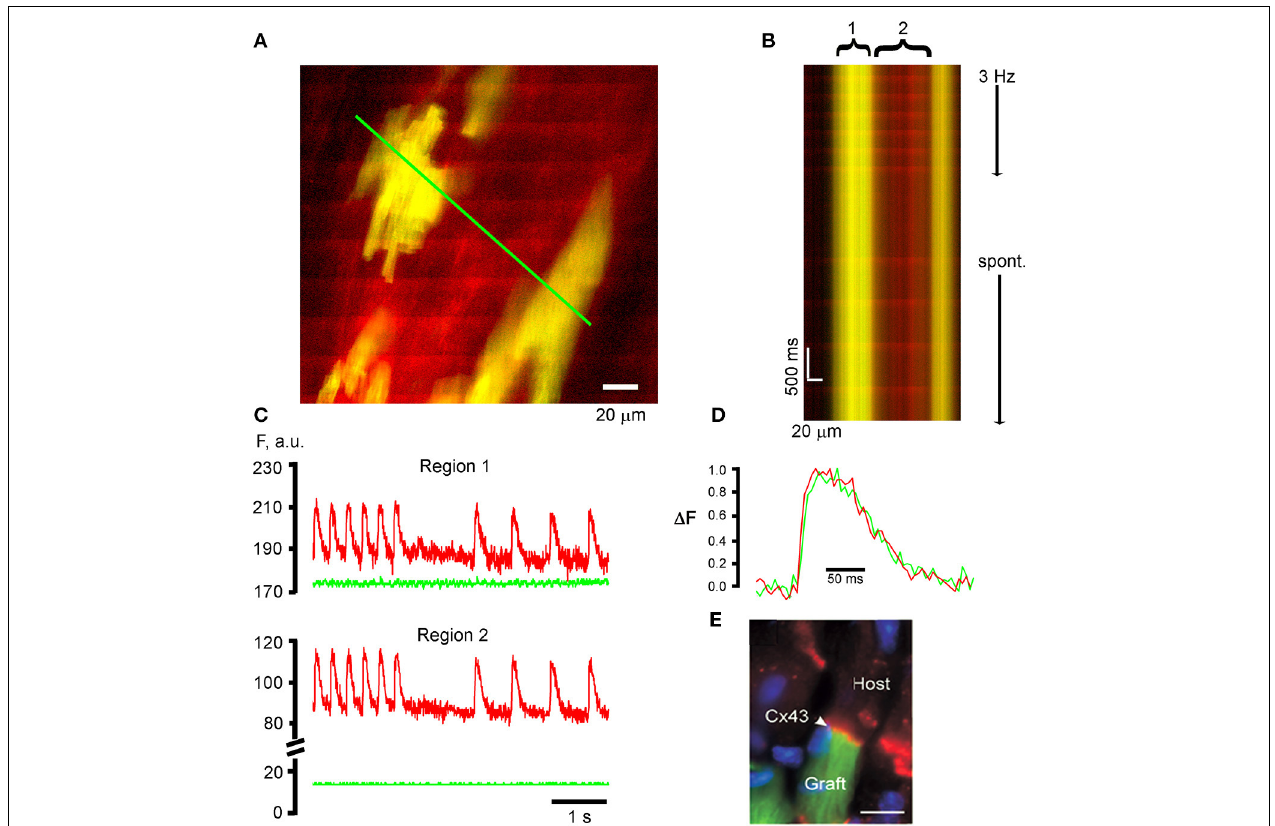
FIGURE 3 | TPLSM [Ca 2 + ] i imaging for functional assessment of intracardiac donor cell transplants. (A) PSC-derived cardiomyocytes participate in a functional syncytium with the host myocardium following their intracardiac transplantation. The frame mode image was taken from a rhod-2—loaded, Langendorff-perfused mouse heart at 21 days following intracardiac injection of 1,00,000 EGFP-expressing, PSC-derived cardiomyoctyes into a non-expressing mouse heart. Donor myocytes appear yellow due to the overlap of red rhod-2 fluorescence and green EGFP fluorescence. Periodic, ripple-like elevations in rhod-2 fluorescence intensity correspond to remote electrical stimulation (3Hz)-evoked [Ca 2 + ] i transients. (B) Line-scan image that was obtained by repeatedly scanning along the green line in (A) (500Hz line-scan rate) and stacking consecutive line-scans